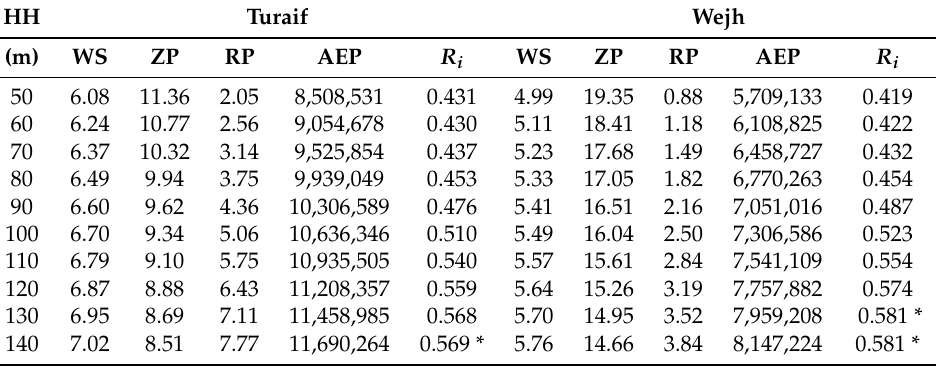
Table A15. TOPSIS analysis for turbine Windtec FC 3000-130. The best choice for each site is marked with an asterisk. HH Turaif